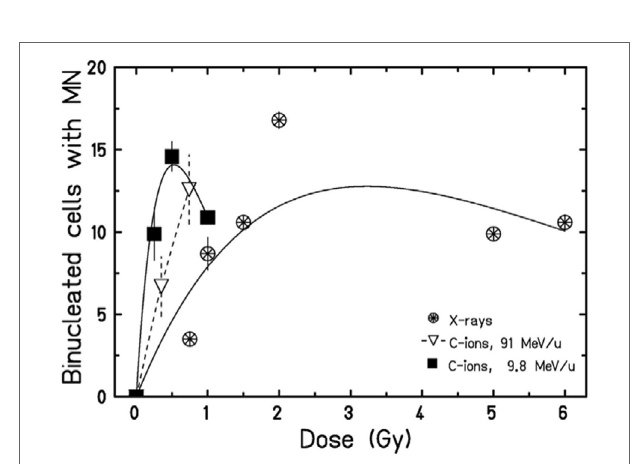
FiGURe 5 | Dose-response curves for the induction of MN in HUVEC cells exposed to X-rays or accelerated carbon ions at two different energies. A curvature at high doses can be observed. Figure reproduced with permission from Ref. (67).